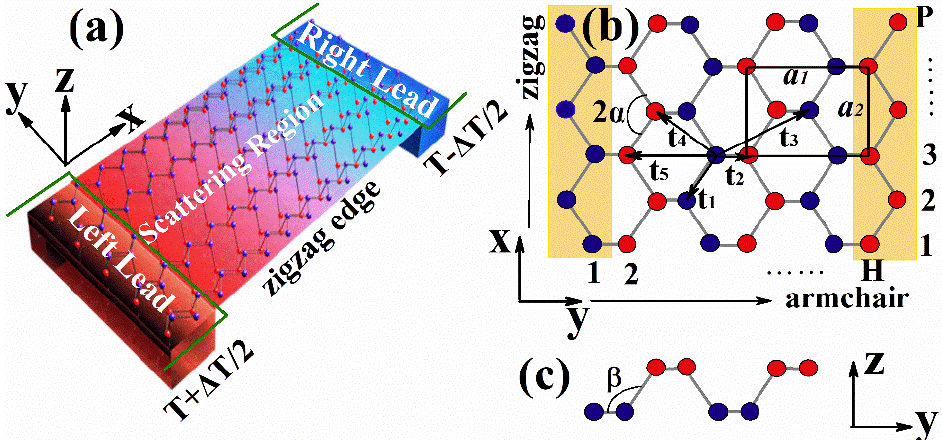
Figure 1. Schematic illustration of the proposed thermoelectric device. ( a ) A zigzag phosphorene nanoribbon is attached to hot and cold macroscopic reservoirs. ( b ) Top and ( c ) side views of the crystal structures of monolayer phosphorene. The hopping integrals, t i , between the phosphorus atoms are shown. The dimensions of a ribbon can be determined by number of atoms on the edges H and P.